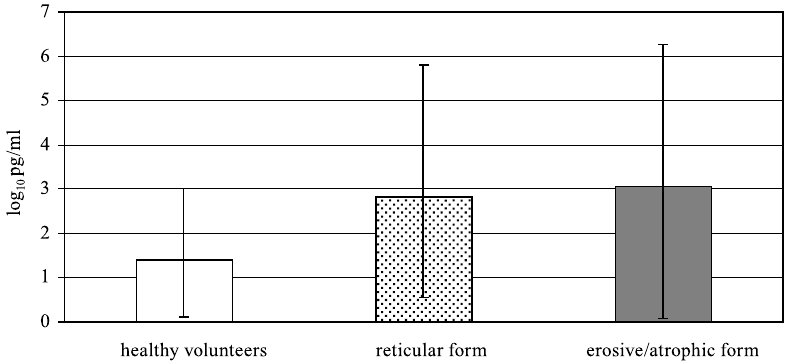
FIG. 1. The levels of TNF- a in the saliva samples from healthy volunteers and patients with the reticular form or the erosive/ atrophic form of OLP. Data represent the median log 10 cytokine content (IQR) per milliliter of saliva derived from 20 subjects. Significance: healthy volunteers versus reticular and erosive/atrophic forms (p B / 0.0001), and reticular form versus erosive/ atrophic form of OLP (p B /